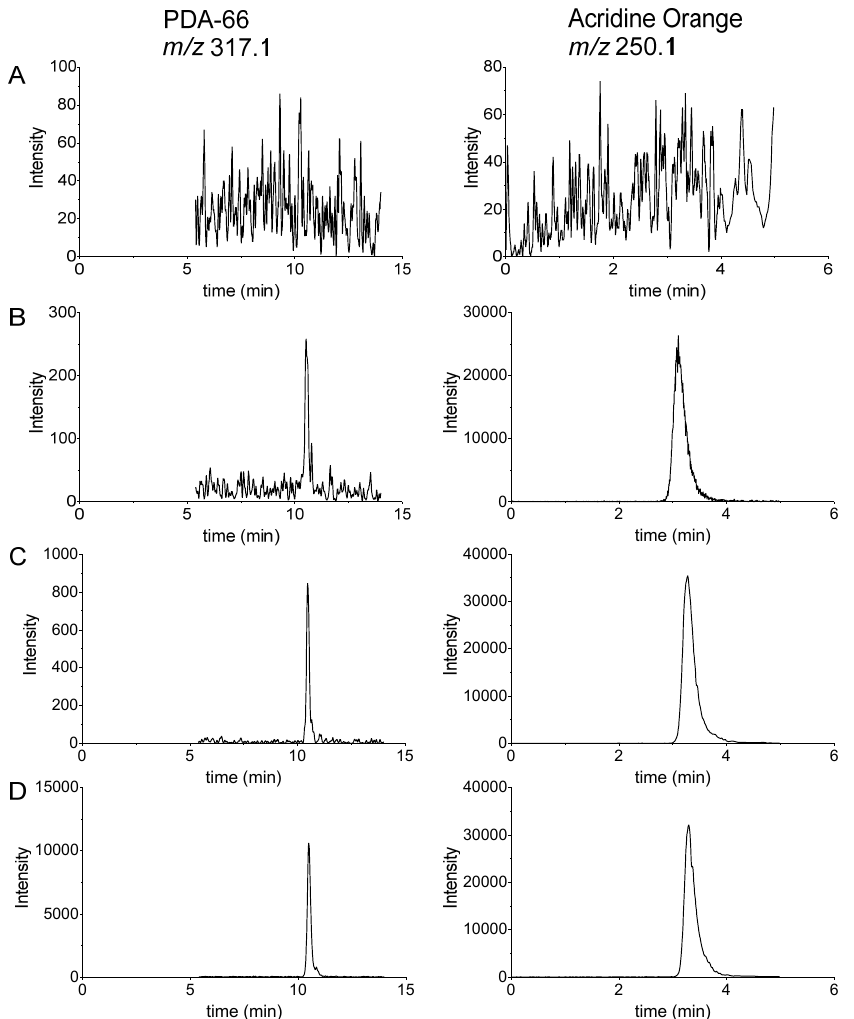
Figure 3. Chromatograms from LC-MS/MS analysis of ( A ) a blank sample, ( B ) a sample containing 2.5 nM PDA-66 (LLOQ), ( C ) a 7.5 nM PDA-66 standard sample and ( D ) a 100 nM PDA-66 standard sample. Shown are exemplary chromatograms of the quantification ions for PDA-66 and acridine orange (internal standard). Not shown are the qualifier ions for PDA-66 ( m/z 230.2) and the internal standard ( m/z 234.1).